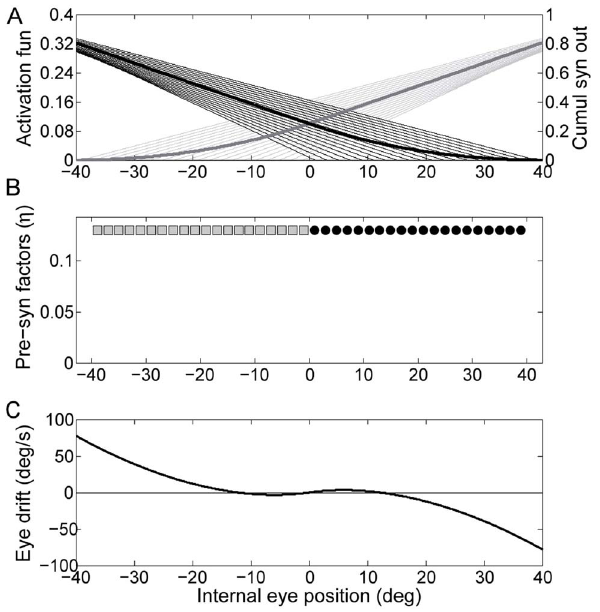
Figure 6. Simulation of the network tuned with non-uniform error function. The Gaussian function of the eye eccentricity represented by the solid line in the central panel has been multiplied to the resulting drift, i.e. the error to minimize, during the optimization procedure. The contents of the panels are as in figure 1A.